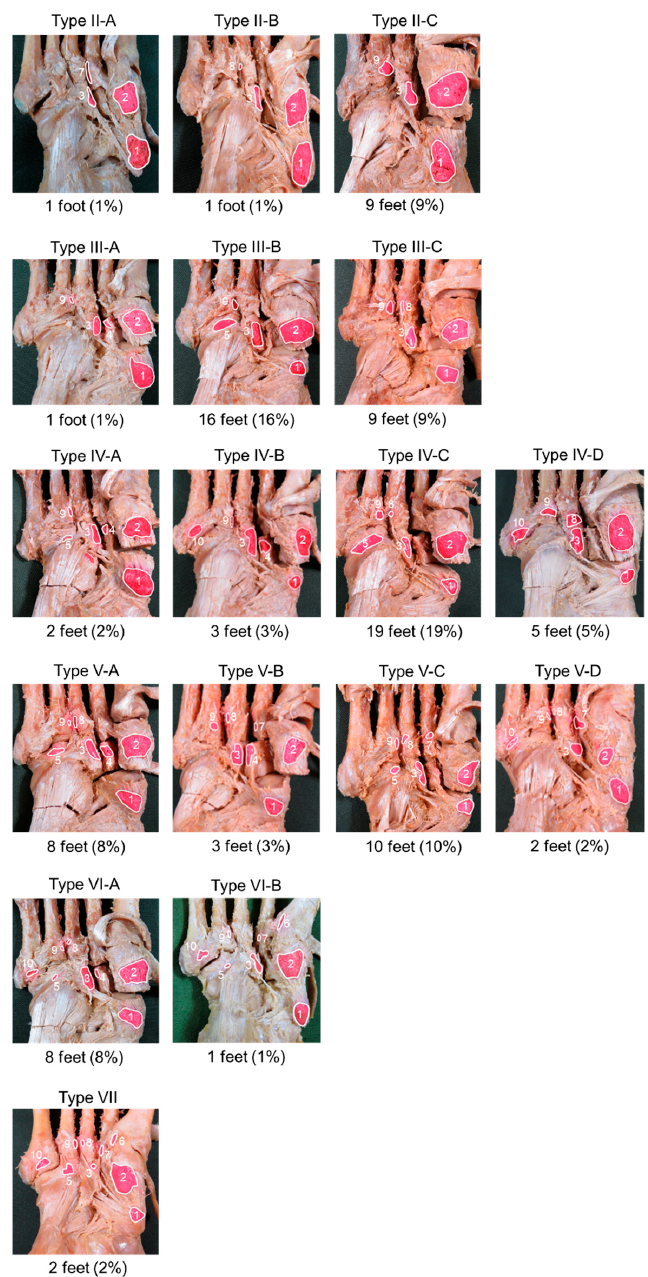
Figure 2. Type classification of the tibialis posterior tendon. 1, Navicular bone; 2, medial cuneiform bone; 3, lateral cuneiform bone; 4, intermediate cuneiform bone; 5, cuboid bone; 6, 1st metatarsal bone; 7, 2nd metatarsal bone; 8, 3rd metatarsal bone; 9, 4th metatarsal bone; 10, 5th metatarsal bone; M, medial; L, lateral. Type II: In addition to Type I (navicular bone, medial cuneiform bone, and lateral cuneiform bone), there is one additional site of attachment, with attachment to a total of four sites. A: 2nd metatarsal bone. B: 3rd metatarsal bone. C: 4th metatarsal bone. Type III: In addition to Type I, there are two additional sites of attachment, with attachment to a total of five sites. A: Intermediate cuneiform bone, 4th metatarsal bone. B: Cuboid bone, 4th metatarsal bone. C: 3rd met- atarsal bone, 4th metatarsal bone. Type IV: In addition to Type I, there are three additional sites of attachment, with attachment to a total of six sites. A: Intermediate cuneiform bone, cuboid bone, 4th